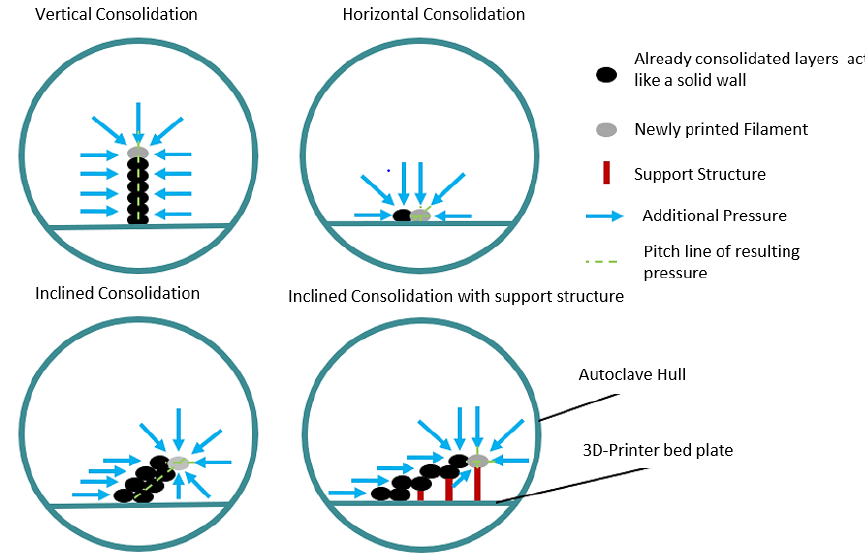
Figure 10. Pressure gradient during FDM 3D-printing under ambient pressure ‘p’.